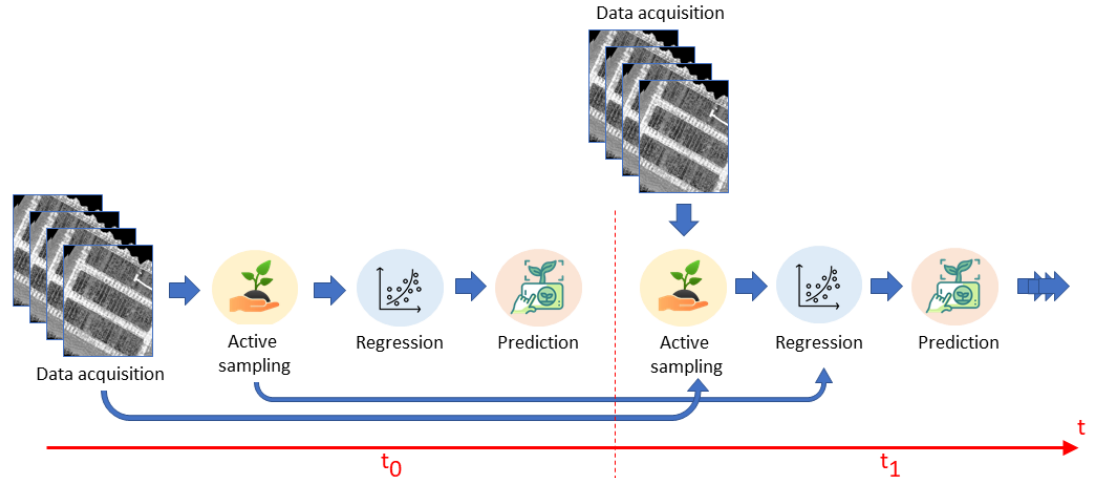
Figure 2. Proposed workflow. The active sampling procedure is fed by any observation available. Regression is implemented using all the data available at time t i to generate the prediction of the biophysical variable of interest.